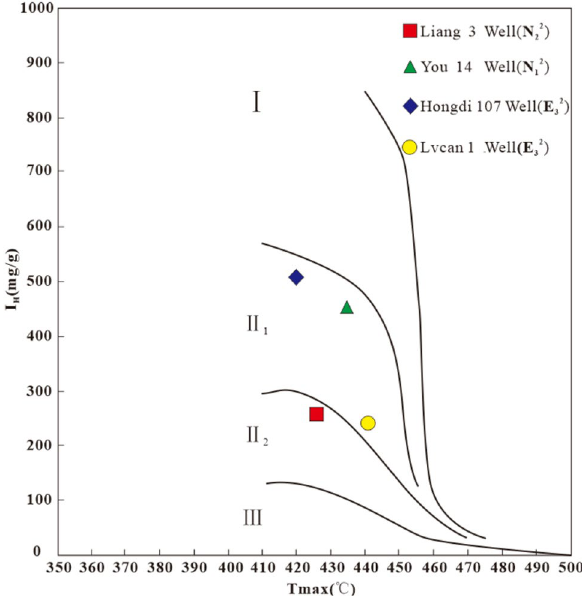
Fig. 2 Classification of organic matter based on hydrogen index and hydrogen index and hydrocarbon pyrolysis peak